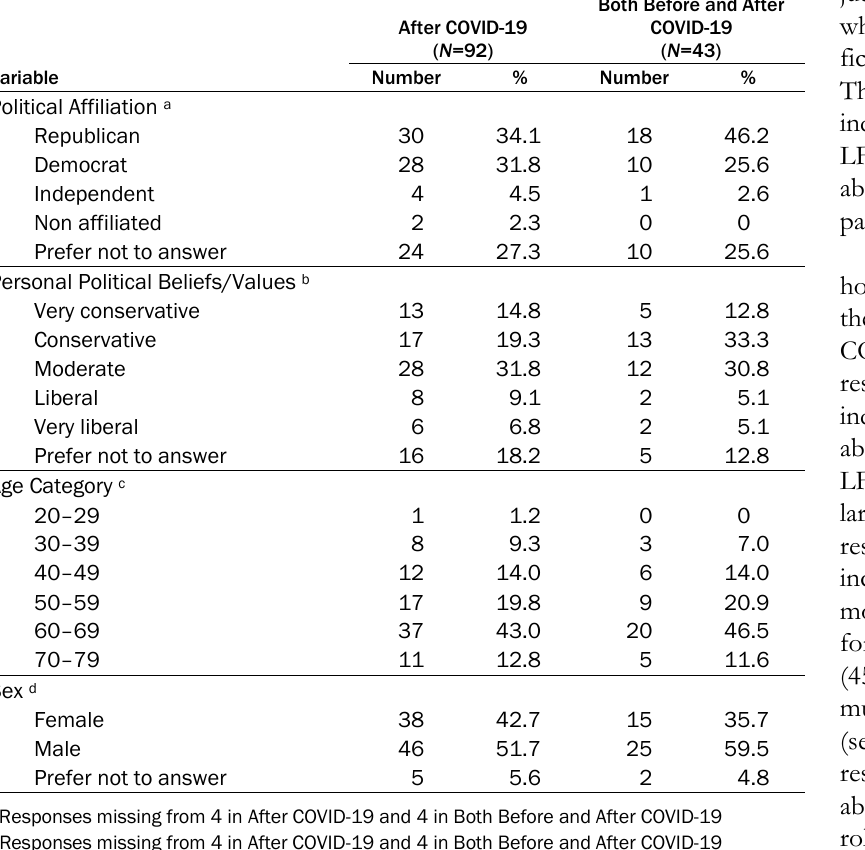
Table 2. Personal Characteristics of Respondents